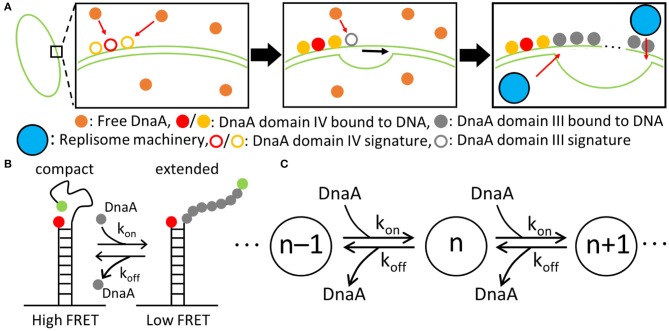
Replication initiation mechanism. (A) DnaA(IV) binds to three signatures on dsDNA next to the AT-rich region near oriC. DnaA(III) subsequently binds in 3-nucleotide increments. DnaA(III) continues to bind to ssDNA until the AT-rich region is opened, allowing the replisome machinery to be loaded. (B) The kinetic parameters for the binding of DnaA(III) to ssDNA were obtained from a smFRET study (Cheng et al., 2014) where the FRET signal depended on the number of DnaA bound. Fewer DnaA corresponded to compact ssDNA, resulting in a high FRET signal. Increasing the number of DnaA bound to ssDNA extends the filament, lowering the FRET signal. (C) Schematic of the binding kinetics of DnaA(III) to ssDNA forming a DnaA filament of length n. The kon and koff values correspond to the kinetics measured by smFRET.